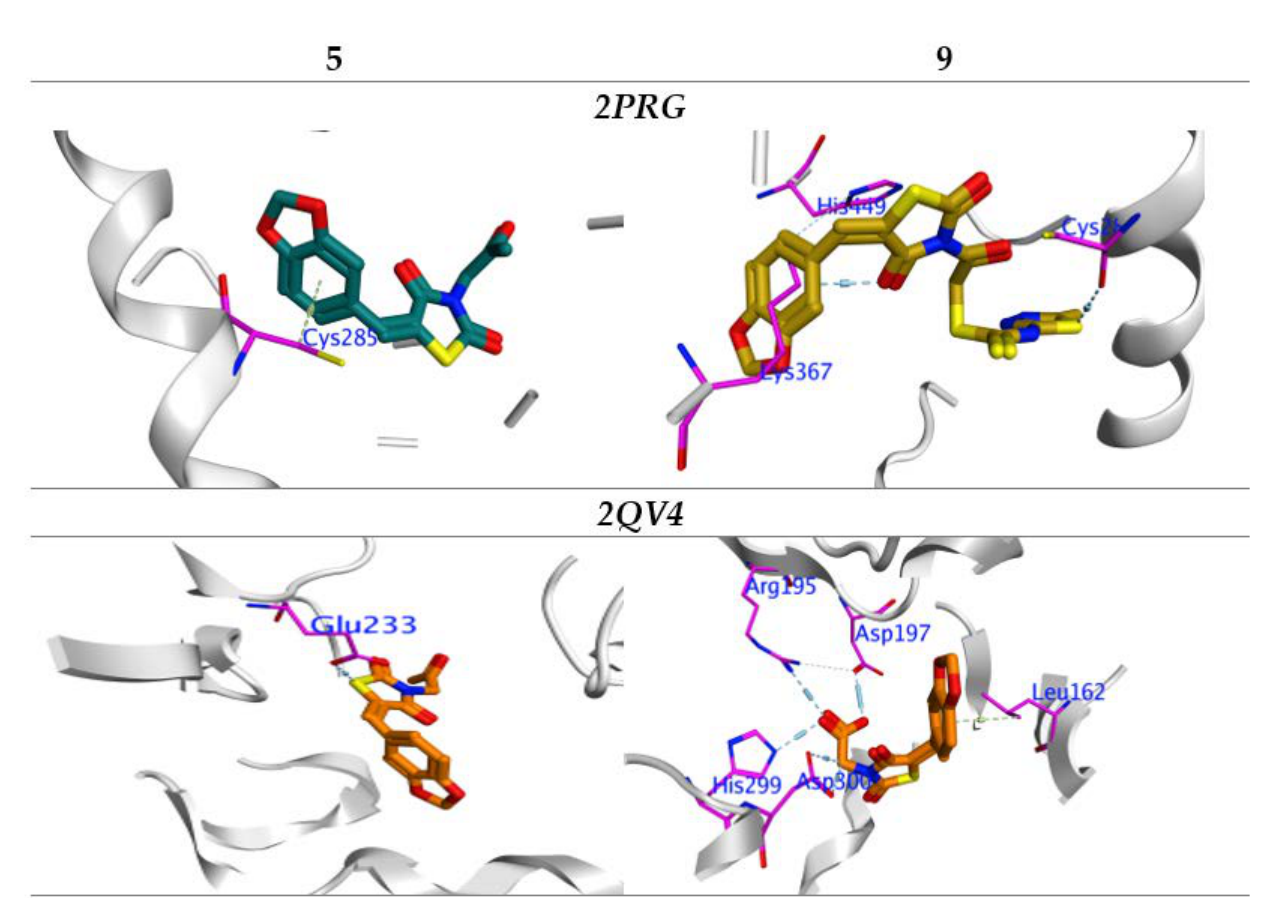
Figure 4. Interaction between ligands 5 and 9 with 2PRG and 2QV4 binding sites, which blue lines represented hydrogen bonding